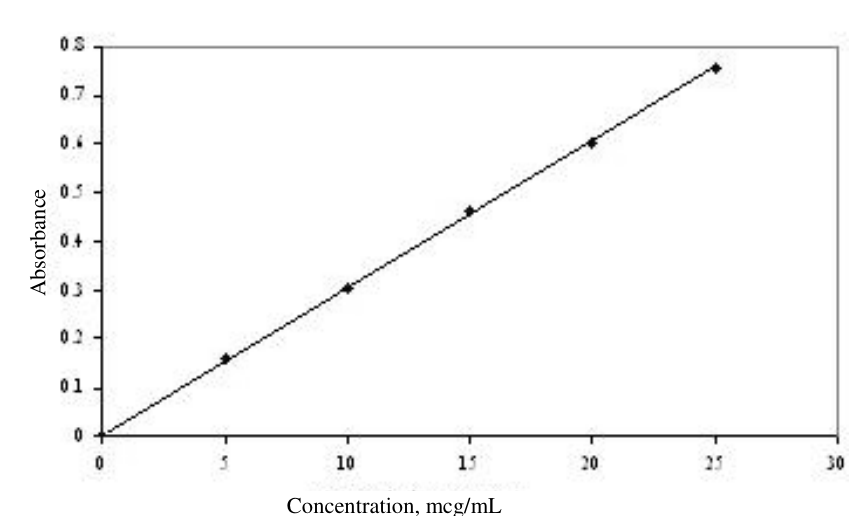
Figure 3 . Standard plot of valacyclovir